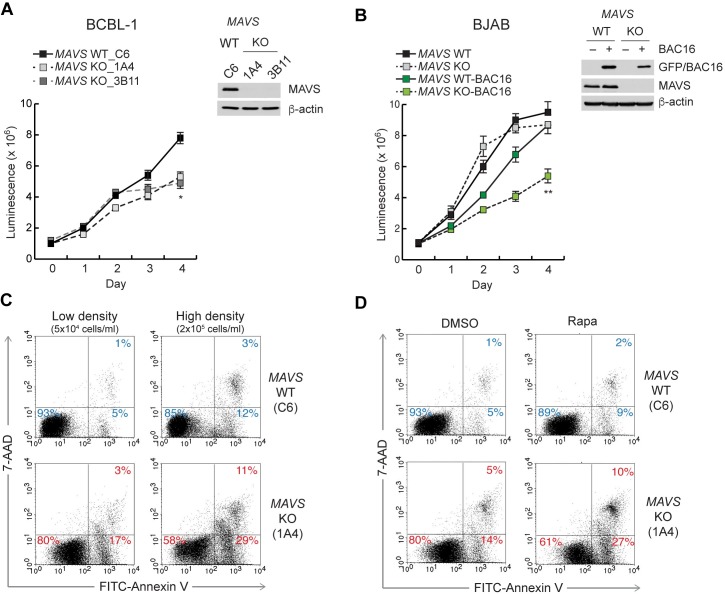
Increased death of HHV-8-infected MAVS-deficient cells.(A-B) Growth curve of wild-type (WT) and MAVS knockout (KO) BCBL-1 cell lines (A) and BJAB cells infected or uninfected with HHV-8 BAC16 virus (B). Cell viability was assessed by determining ATP levels using CellTiter-Glo for 4 days. MAVS and GFP expression were determined on day 0 by immunoblot as shown next to each graph. Data are presented as mean ± SD of triplicate samples. Probability (p) values at day 4 are depicted; * p<0.05 and ** p<0.01. (C-D) Flow cytometry analyses of annexin V-FITC and 7-AAD in WT and MAVS KO BCBL-1 (1A4) cells seeded at 5x104 and 2x105 cells/ml and incubated for 2 days (C) and seeded at 5x104 cells/ml and treated with 20 nM rapamycin (Rapa) for 2 days (D). The percentage of total cells in each quadrant is shown.